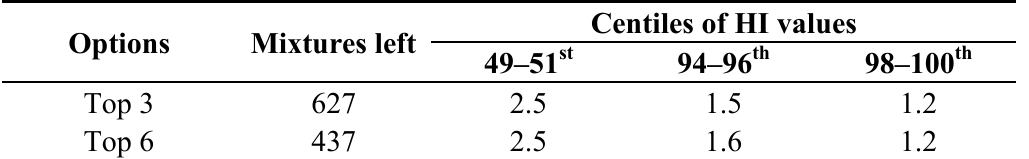
Table 1. Impact of the two exclusion criteria (missing value in top three or top six compounds) on mean MCR values in three portions of the mixtures. Portions are determined by ranking mixtures and selecting mixtures that fall within three ranges of HI centiles (49–51, 94–96, and 98–100 centiles).